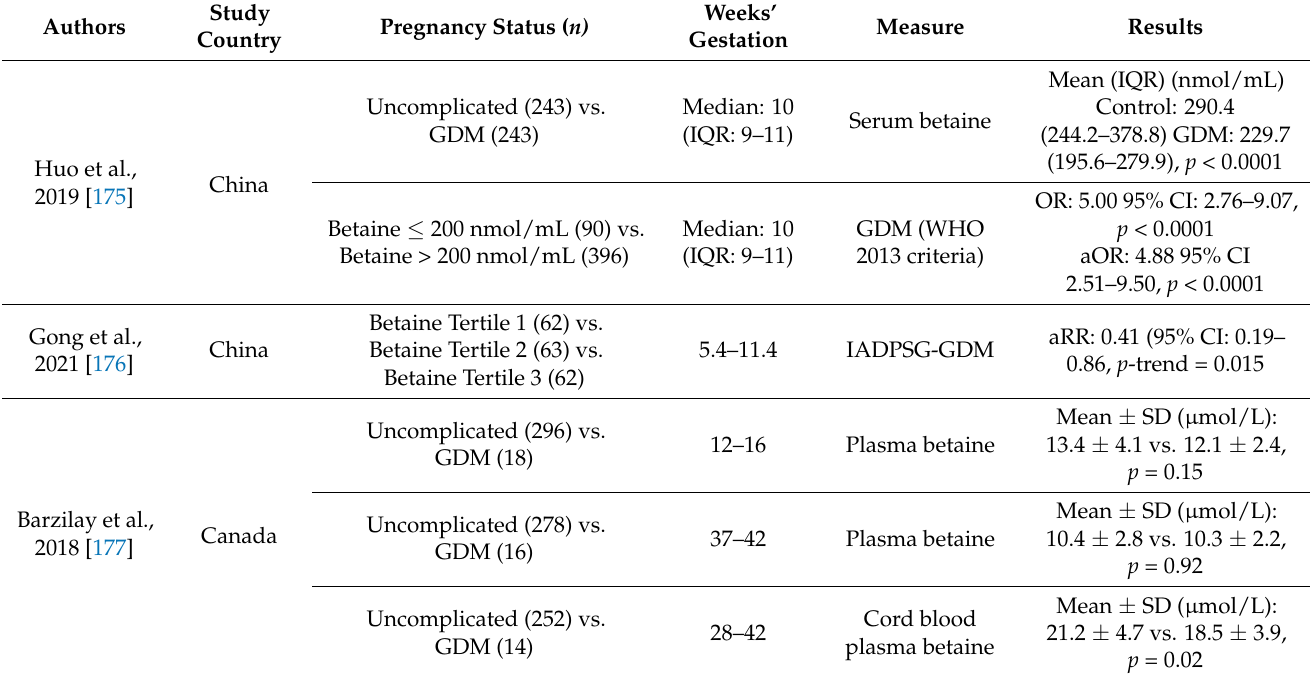
Table 4. Summary of research on the relationship between betaine and